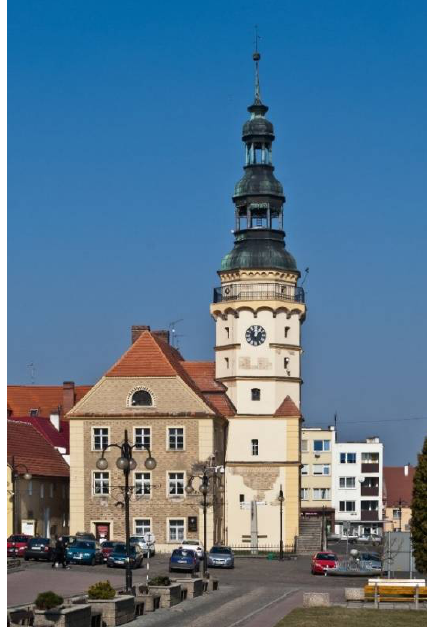
Figure 15. Town hall in Otmuchów. Photo by J. Halicki 2014. Source: Wikimedia Commons: Ot-